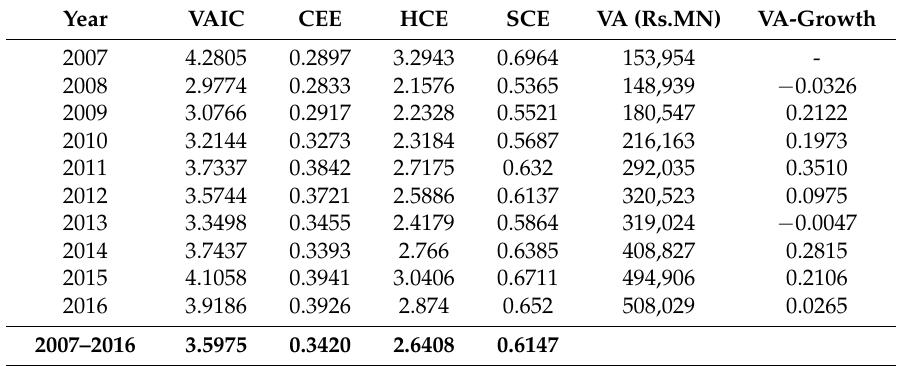
Table 1. Trend in value added intellectual coefficient (VAIC) TM and its components of the Pakistani banking